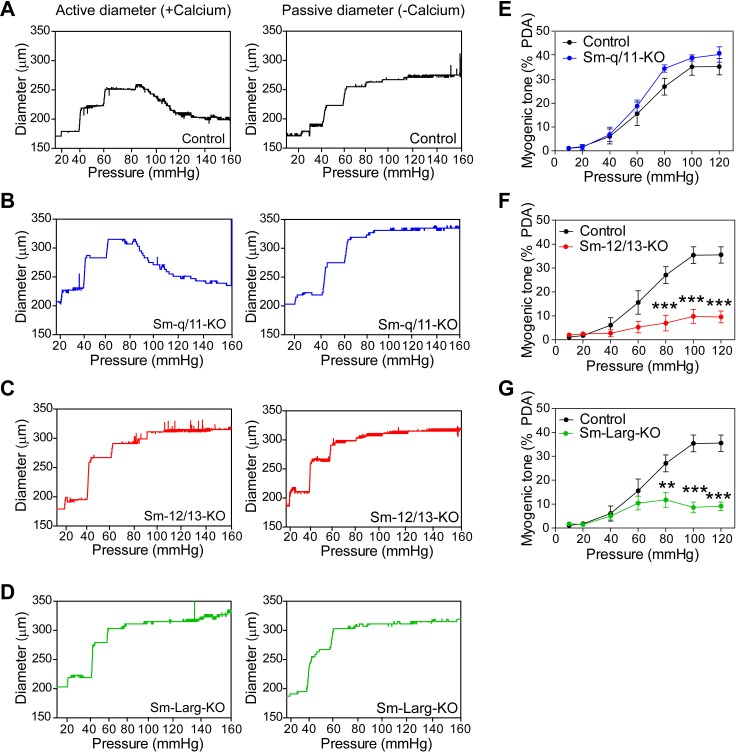
Effect of vascular smooth muscle-specific Gαq/Gα11, Gα12/Gα13, and ARHGEF12 (LARG) deficiency on myogenic tone responses.(A-D) Representative traces of first order mesenteric arteries isolated from control (A, black), Sm-q/11-KO (B, blue), Sm-12/13-KO (C, red) and Sm-Larg-KO (D, green) mice showing changes in the luminal diameter over a range of increased perfusion pressure (10–140 mmHg) in the presence (active diameter, left panels) and absence of calcium (passive diameter, right panels).(E–G) Third order mesenteric arteries were isolated from control (black circles), Sm-q/11-KO (blue circles) and Sm-12/13-KO (red circles) mice and were pressurized with the indicated pressure steps. The myogenic tone was determined as described above (n = 7 mice (control), n = 5 mice (Sm-12/13-KO and Sm-Larg-KO)). All values are mean values ± SEM. **, p≤0.01; ***, p≤0.001 (2-way ANOVA and Bonferroni’s post-hoc test).